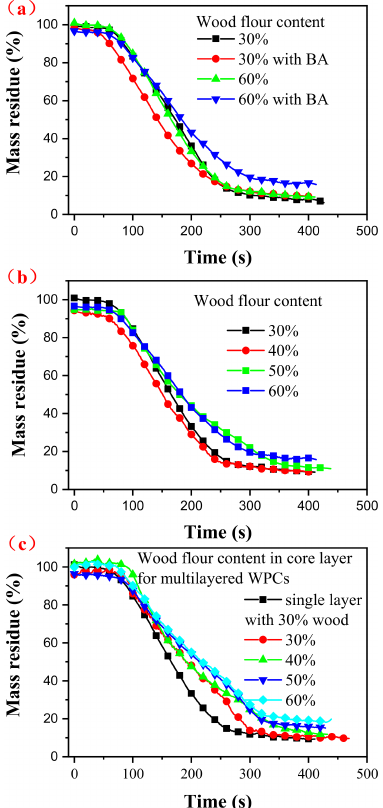
Figure 5. Combustion parameters of the multilayered wood flour/HDPE/PC composites. ( a ) heat release rate (HRR), ( b ) total heat release THR, ( c ) smoke production rate (SPR), and ( d ) total smoke production (TSP).